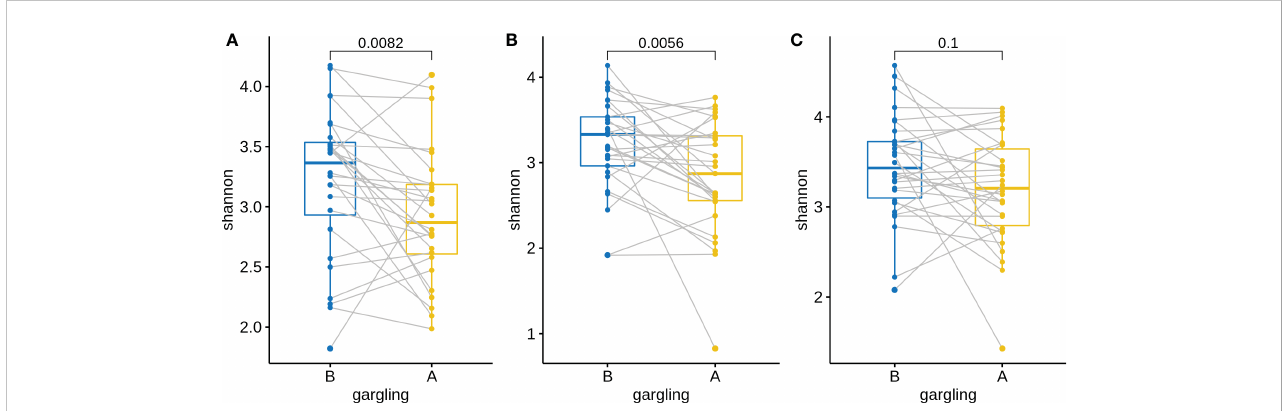
FIGURE 4 Shannon indices of oral microbiota in paired samples before (B) and after (A) gargling of mouthwash groups (A) C, (B) L, and (C) N. For each group, paired Wilcoxon rank test p-value is shown.